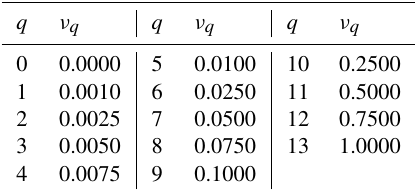
Table B1. Bin limits for the imaginary part of the refractive